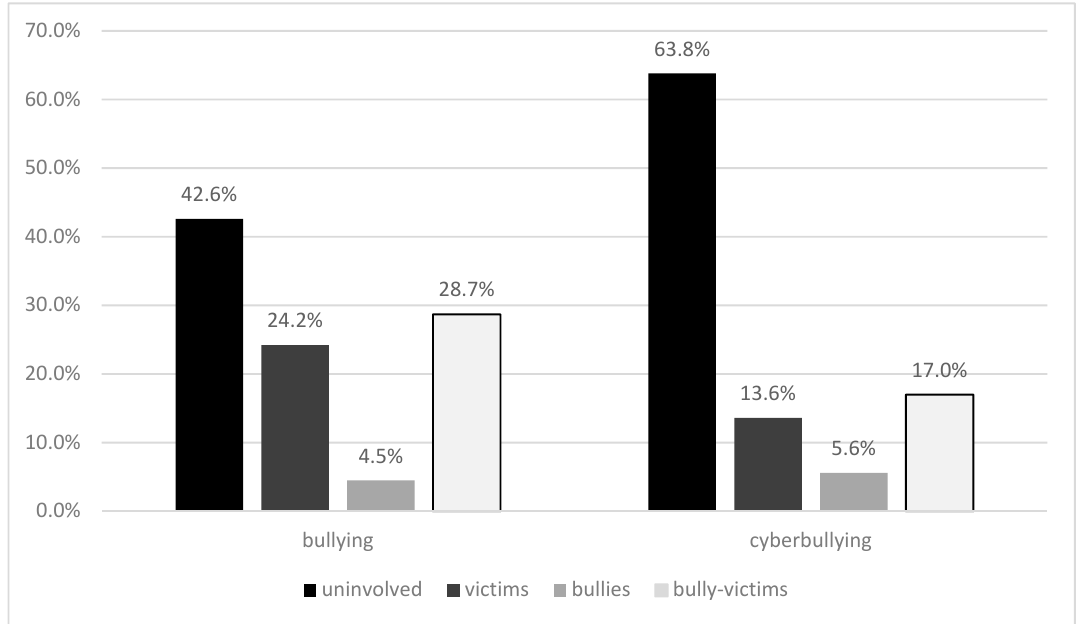
Figure 3. Prevalence rates of involvement in different bullying and cyberbullying roles.